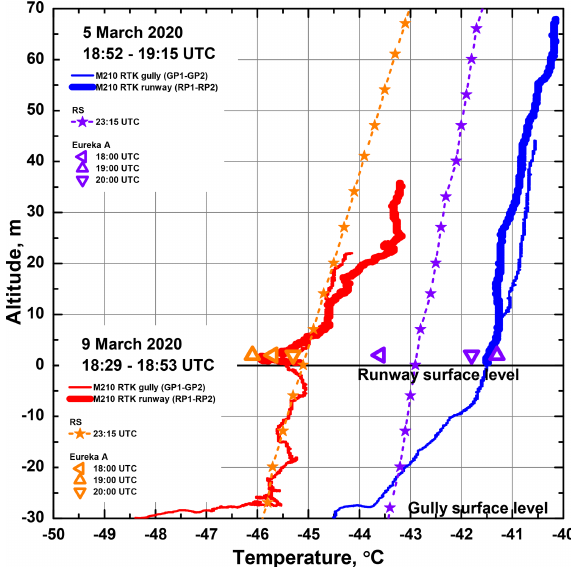
Figure 12. Temperature profiles measured during M210 RTK gully versus runway flights on 5 and 9 March 2020 featuring different shapes of SBI formed in the gully and above the runway (see Fig. 7 for the locations of the temperature profiles).